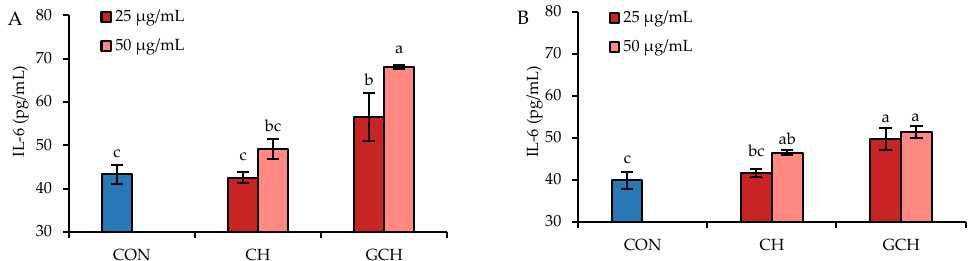
Figure 3. IL-6 secretion in IEC-6 cells treated with casein hydrolysate (CH) and glycated casein hydrolysate (GCH) for 12 h ( A ) and 24 h ( B ). The abbreviation “CON” stands for the control cells without sample treatment, while the one-way ANOVA of the mean values with different lowercase letters above the columns indicates a significant difference ( p < 0.05).